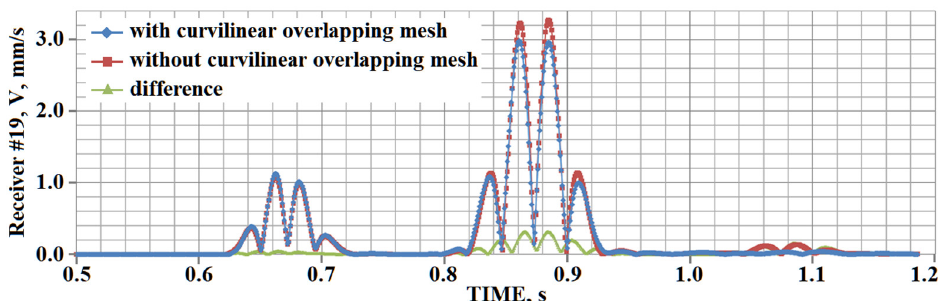
Figure 18. Receiver #19, dependencies of velocity modulus on time.